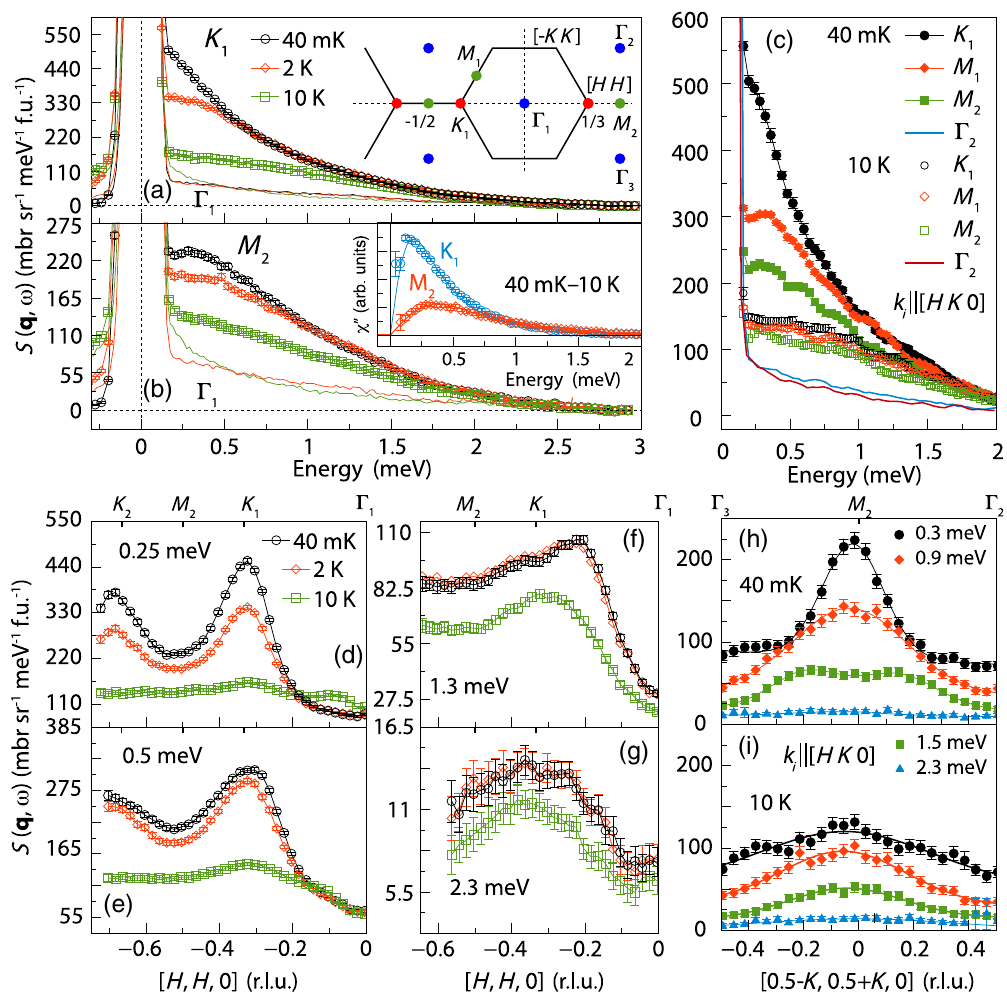
FIG. 5. Wave vector dependence of spin excitations along high symmetry directions. The wave vector cuts in (a),(b),(d) – (g) were measured in the ½ H; H; L (cid:3) zone with E i ¼ 3 . 32 meV, while those in (c),(h),(i) were measured in the ½ H; K; 0 (cid:3) plane with E ¼ 3 . 70 meV. Panels (a) and (b) show the energy-dependent scattering at K i circle), 2 K (red diamond), and 10 K (green square). The inset in (a) is a schematic of the reciprocal space with the Γ , K , and M points denoted by green, red, and blue dots, respectively. The black, red, and green curves are energy cuts at Γ 1 . The inset of (b) shows the difference of χ 00 between the spectra for T ¼ 40 mK and 10 K at the K and M points. The light blue and red curves are fittings of the χ 00 with a damped harmonic oscillator model. Panel (c) shows the energy cuts at the K 1 , M 1 , M 2 , and Γ 2 . Solid symbols represent the data collected at T ¼ 40 mK and the open symbols collected at 10 K. The black and blue curves are energy cuts at the Γ 2 point measured at T ¼ 40 mK and 10 K, respectively. (d) – (g) Constant energy cuts along the M corresponding energy transfers marked in the panels. Constant energy cuts along the Γ 3 - M 2 - Γ 2 measured at (h) T ¼ 40 mK and (i) 10 K. The solid curves are guides to the eyes, and the error bars represent one standard